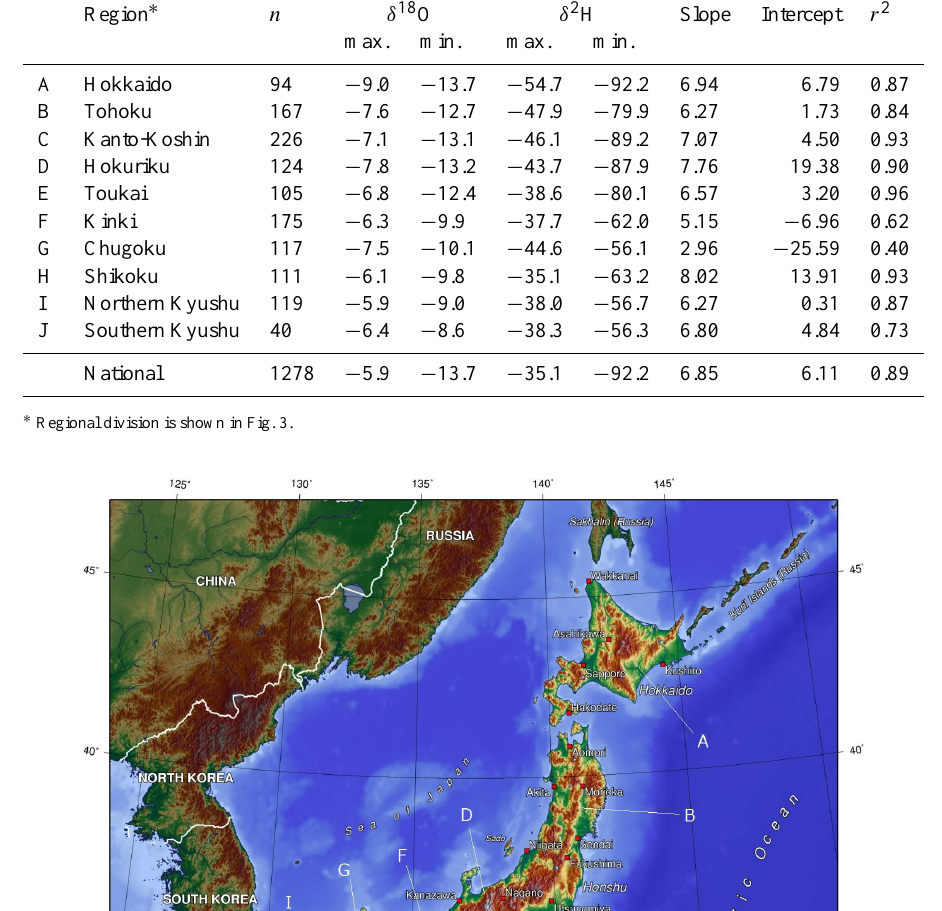
Table 2. Range of δ 18 O and δ 2 H values in stream water samples and liner regressions for each region. Region ∗